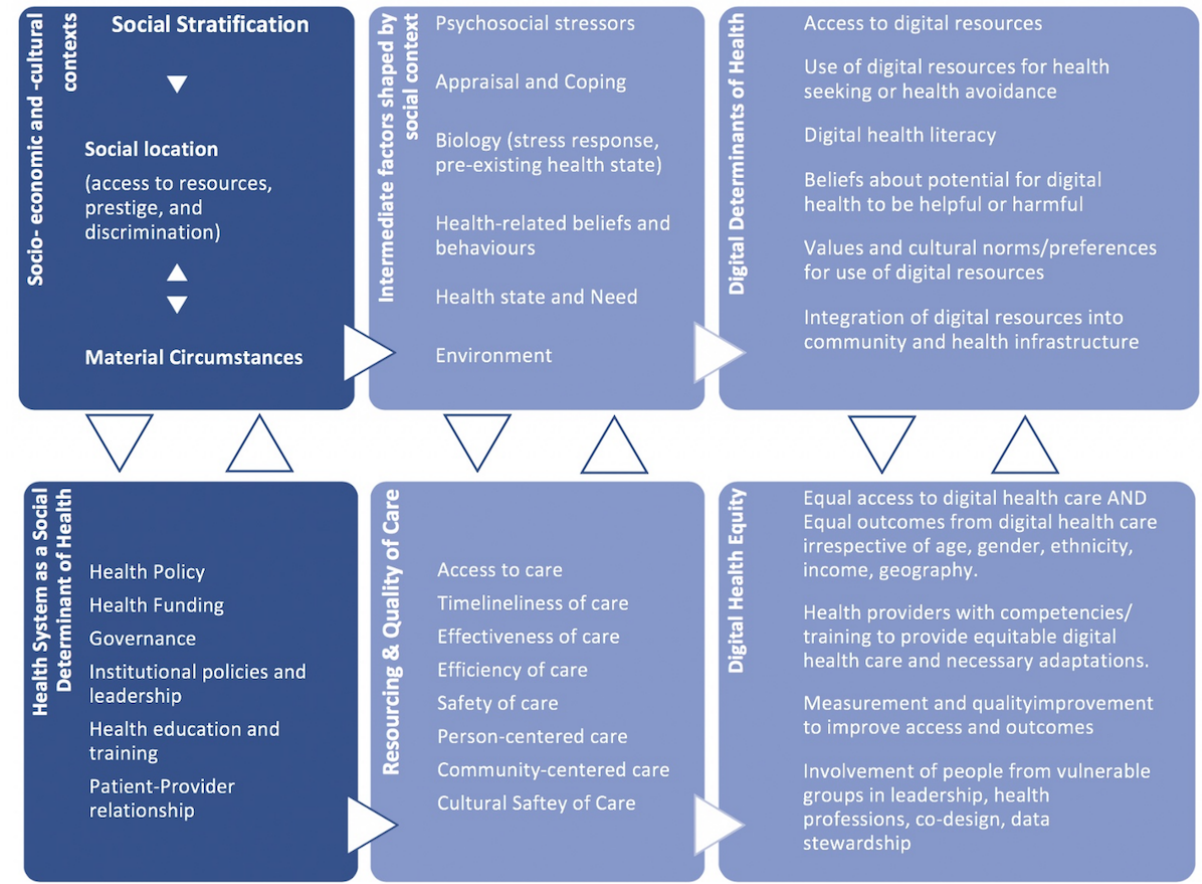
Figure 1. Digital Health Equity